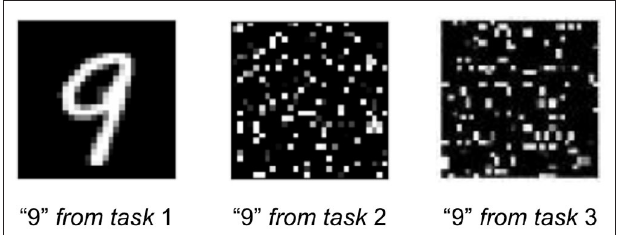
FIGURE 15 | A visual illustration of permutedMNIST. Each task applies a unique pixel-wise permutation to the same original image (leftmost image) while preserving the target label. A model’s task is to identify the digit in each case regardless of permutation.